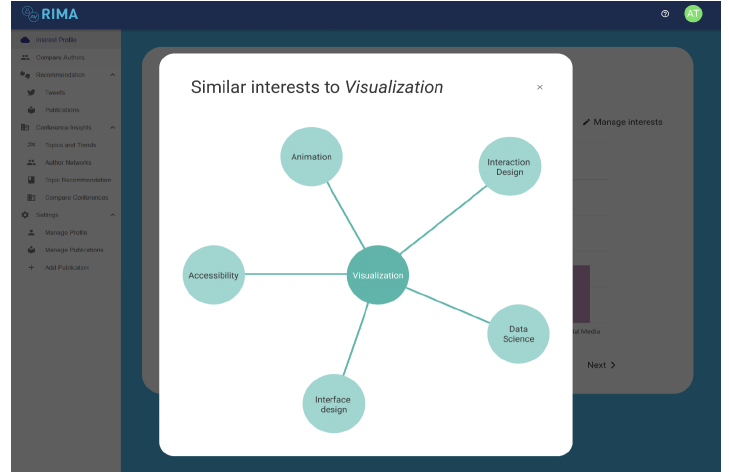
Figure 16. Similar